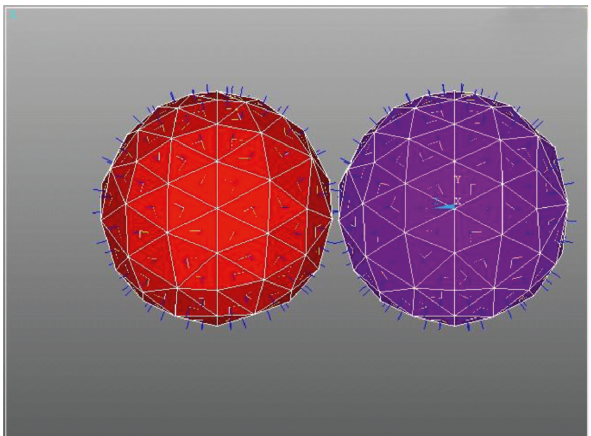
Figure 5: Finite element model in ANSYS.